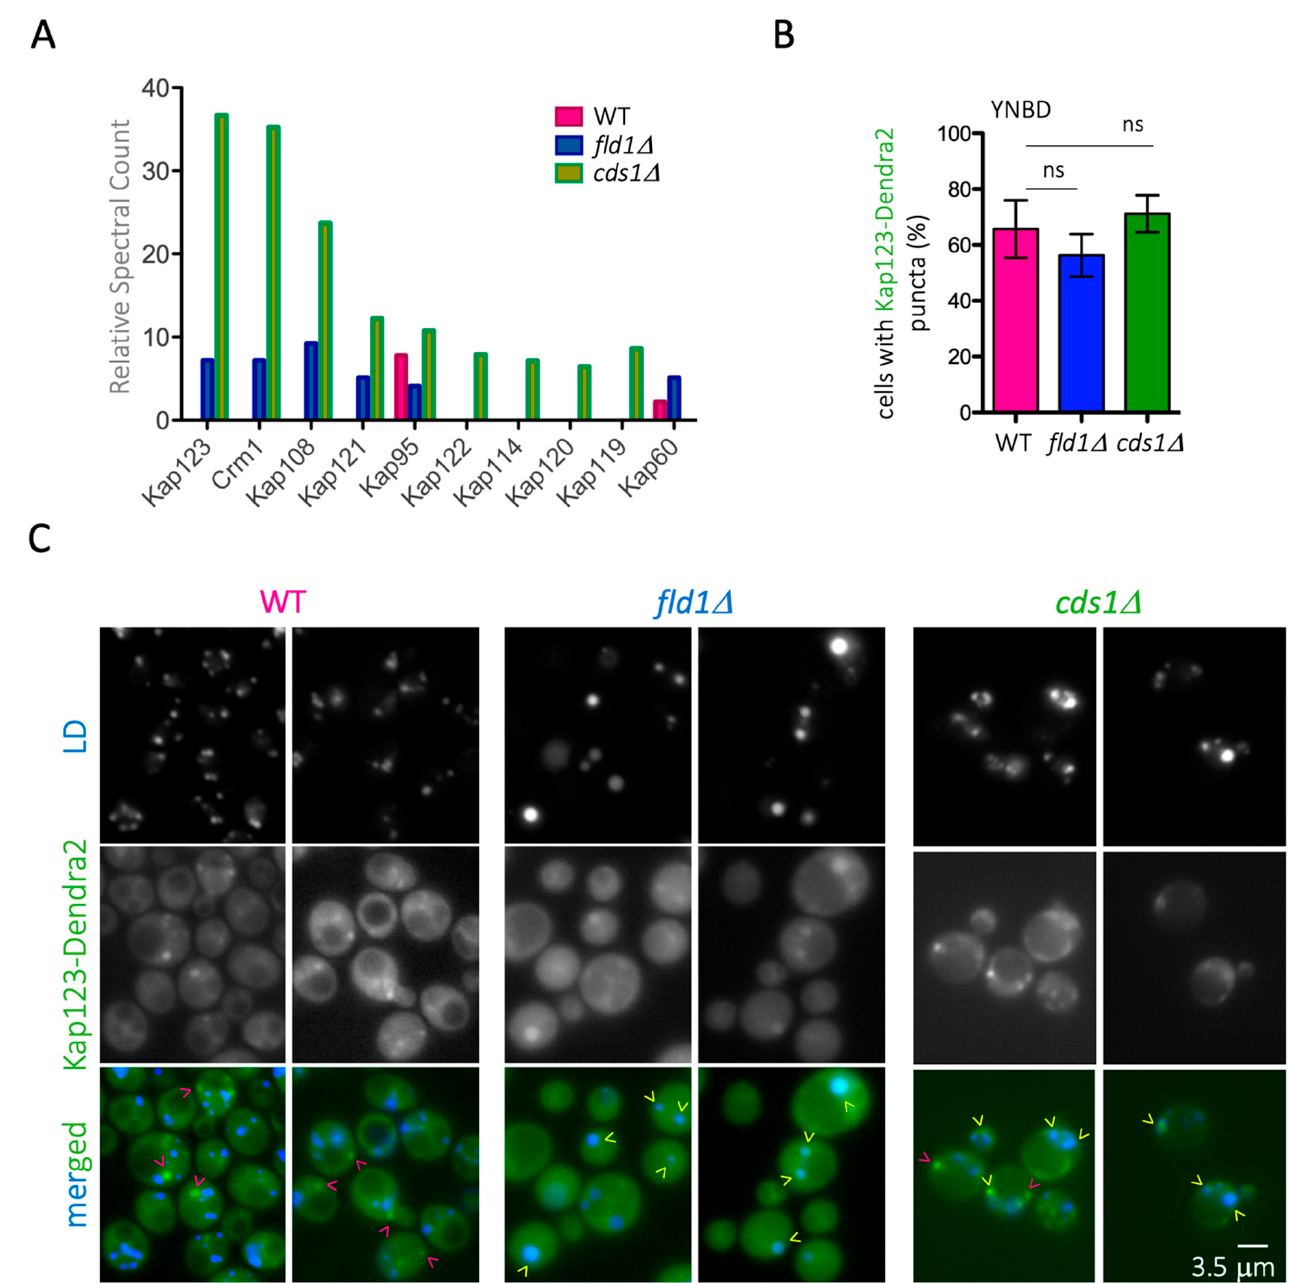
Figure 6. Altered distribution of karyopherins onto mutant LD. ( A ) Graphical representation of the relative presence of karyopherins on the LD of WT, fld1 Δ , and cds1 Δ cells purified from saturated Saccharomyces cerevisiae cultures (raw data reported in [31]). ( B ) Quantification of WT, fld1 Δ , and cds1 Δ cells with Kap123–Dendra2 cytoplasmic puncta upon growth in minimal, defined medium until saturation. Each bar indicates the mean value of three independent experiments. Bars correspond to the SEM of those three independent experiments. The difference of the means after applying a t-test revealed that it was not significant (ns). ( C ) Fluorescence microscopy images from data presented in ( B ) of WT and mutant cells in which Kap123 has been tagged with Dendra2 (2 examples per genotype). AUTODOT TM was used to dye LD. Merged images are shown, to assess eventual co-localization. Yellow arrowheads indicate Kap123–Dendra2 signals that co-localize with LD, while pink arrowheads indicate those that do not co-localize.